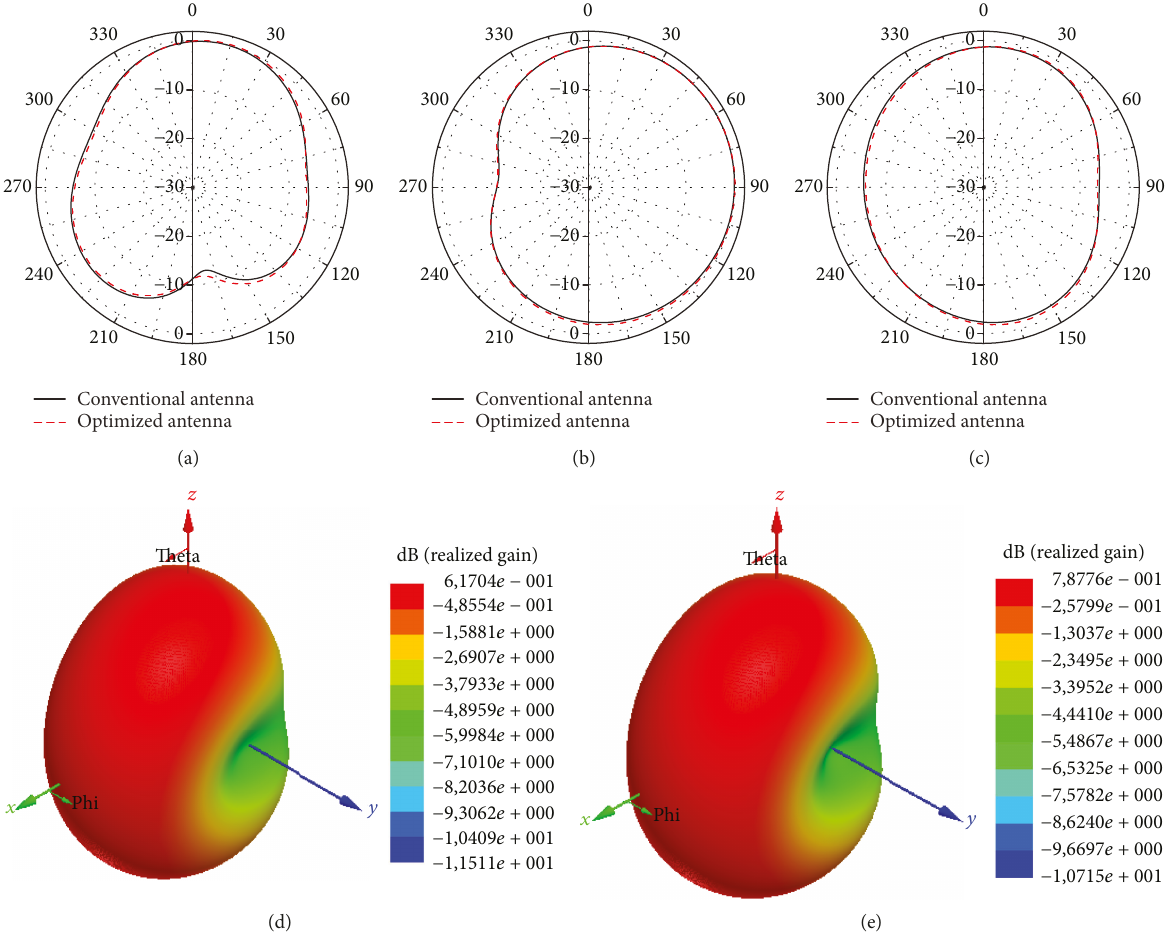
Figure 7: Simulated radiation patterns of the conventional and optimized antennas: (a) xy -plane, (b) xz -plane, (c) yz -plane, (d) 3D radiation pattern of the conventional antenna, and (e) 3D radiation pattern of the optimized antenna. Table 3: OA (9, 4, 3, and 0.2) matrix for the conventional antenna. Table 4: OA (9, 4, 3, and 0.2) matrix for the optimized Experiment